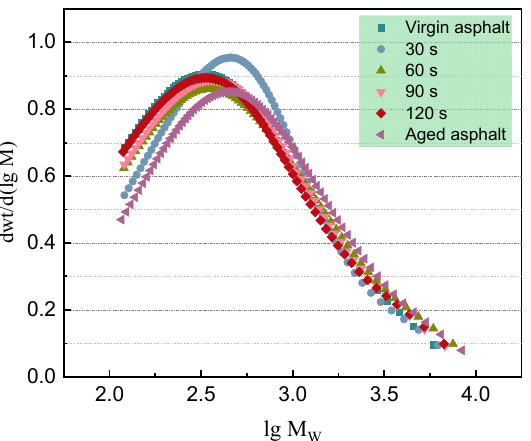
Figure 13. Chromatograms of the asphalt binder with different mixing durations.